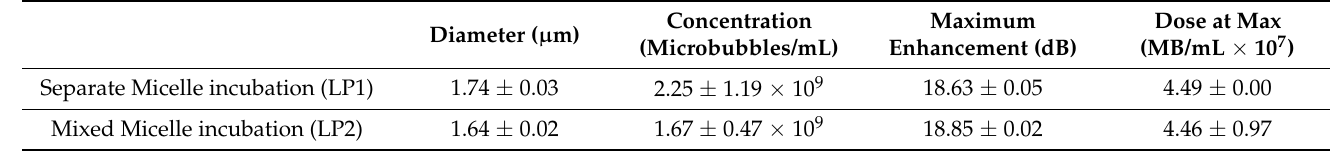
Table 3. Effect of method of dual drug incorporation on microbubble size and concentration, and acoustic behavior.